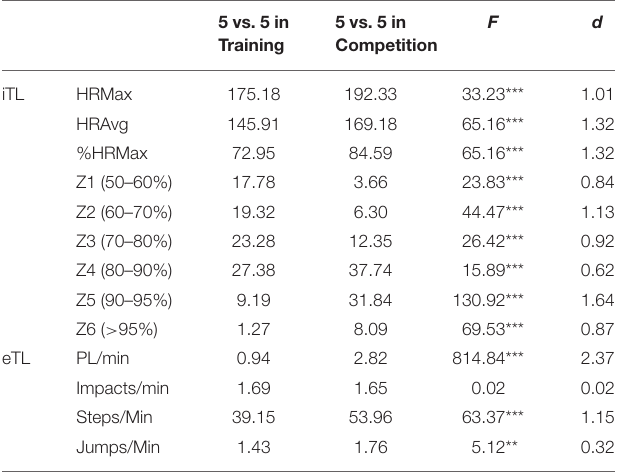
TABLE 1 | Descriptive and inferential results as a function of game situation.